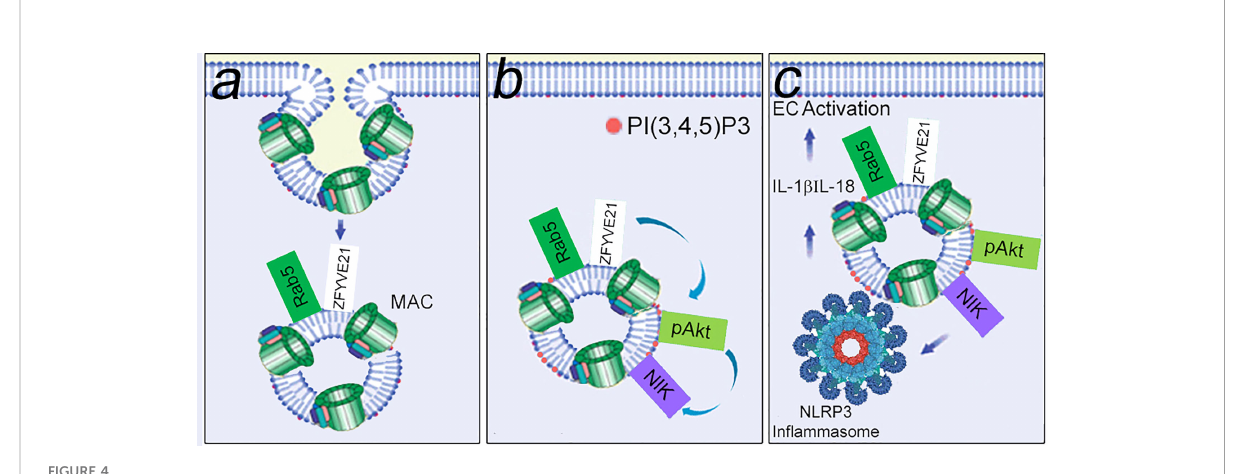
FIGURE 4 MAC-induced signaling endosomes cause EC activation. Non-cytolytic MAC assembled on EC surfaces rapidly undergoes clathrin-mediated endocytosis to form MAC+Rab5+ signaling endosomes that sequester signal-activating elements. In a Rab5-dependent manner, signaling endosomes post-translationally stabilize ZFYVE21, a Rab5 effector. (A) ZFYVE21 recruits SMURF2, an E3 ubiquitin ligase, to mediate degradative removal of PTEN from signaling endosomes, causing enrichment for PI(3,4,5)P3 and recruitment of phosphorylated Akt (pAkt, B ). This process sequentially activates non-canonical NF- k B [marked by NIK (NF-kB Inducing Kinase)], NLRP3 in fl ammasomes, and IL-1 b - mediated canonical NF-kB (C) .